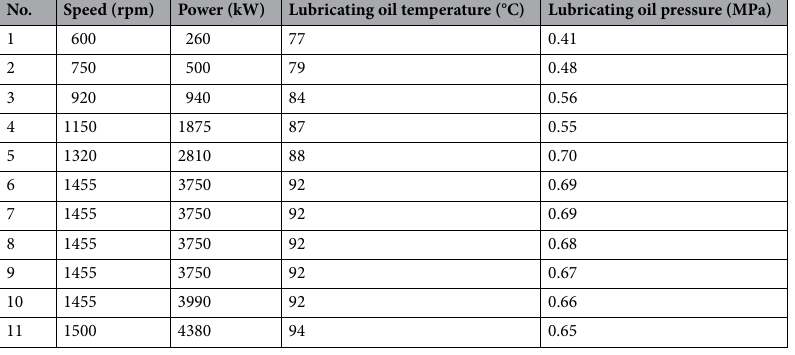
Table 4. Experimental